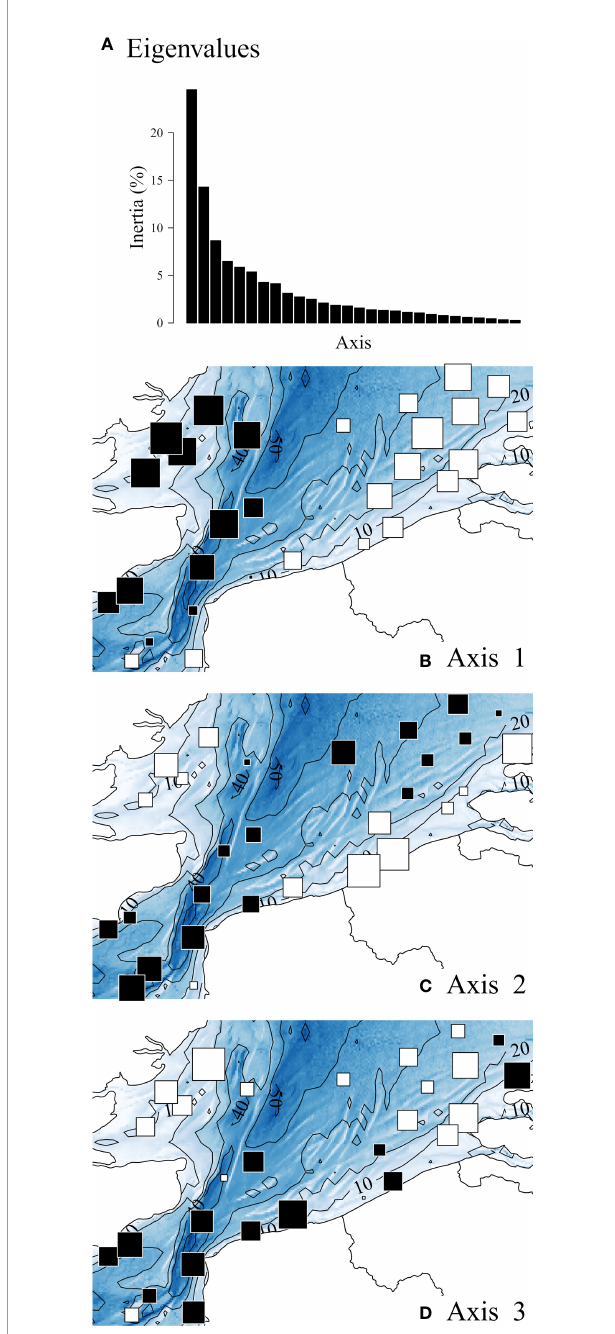
FIGURE 5 | STATIS compromise. (A) Eigenvalue diagram showing three dominant axes: axis 1: 25%; axis 2: 14%; axis 3: 9%. (B – D) Spatial distributions of compromise axis scores. White and black squares, values lower and greater than the mean axis score (0) respectively; square size is proportional to the deviation from the